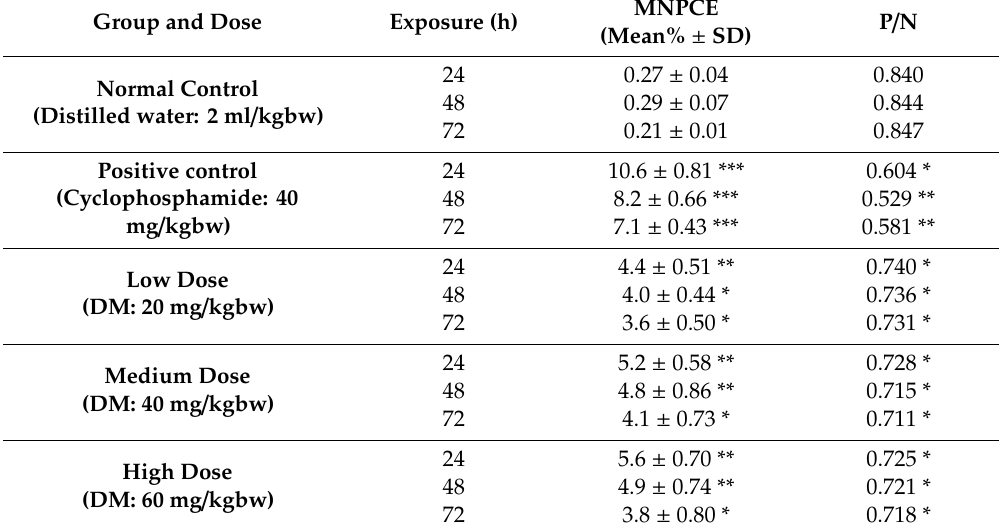
Figure 1. Photomicrograph of Rattus norvegicus bone marrow cells treated with di ff erent concentration of Dimethoate intraperitoneally. Shown are: ( a ) Polychromatic (arrow) and normochromatic (line) eryhthrocytes; ( b ) MNPCE (arrow) along with PCEs and NCEs and metaphase plates for various chromosomal aberrations (c–f); ( c ) Normal metaphase; ( d ) Ring (arrow) and Break (double arrow); ( e ) Chromosomal gap (arrow) and Acentric fragment (double arrow); ( f ) Dicentric (arrow); (100 × oil immersion): Scale bar ( a , b ; 10 µ m) ( c – f ; 40 µ m). Table 1. Mean percent count of micronucleated Polychromatic and Normochromatic erythrocytes (MNPCE and MNNCE) for bone marrow cells of R. norvegicus treated with dimethoate along with respective controls at di ff erent time periods.